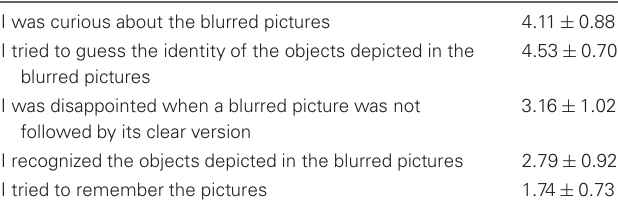
are the cluster-corrected Z statistic maps ( p < 0 . 05) from the ACC/AIC ROI analyses. Lower panel: The colored regions were deactivated when the first picture in a trial was blurred compared to when it was clear. The displayed activations are whole-brain cluster-corrected Z statistic maps ( p < 0 . 05). All activations are overlaid onto the standard MNI